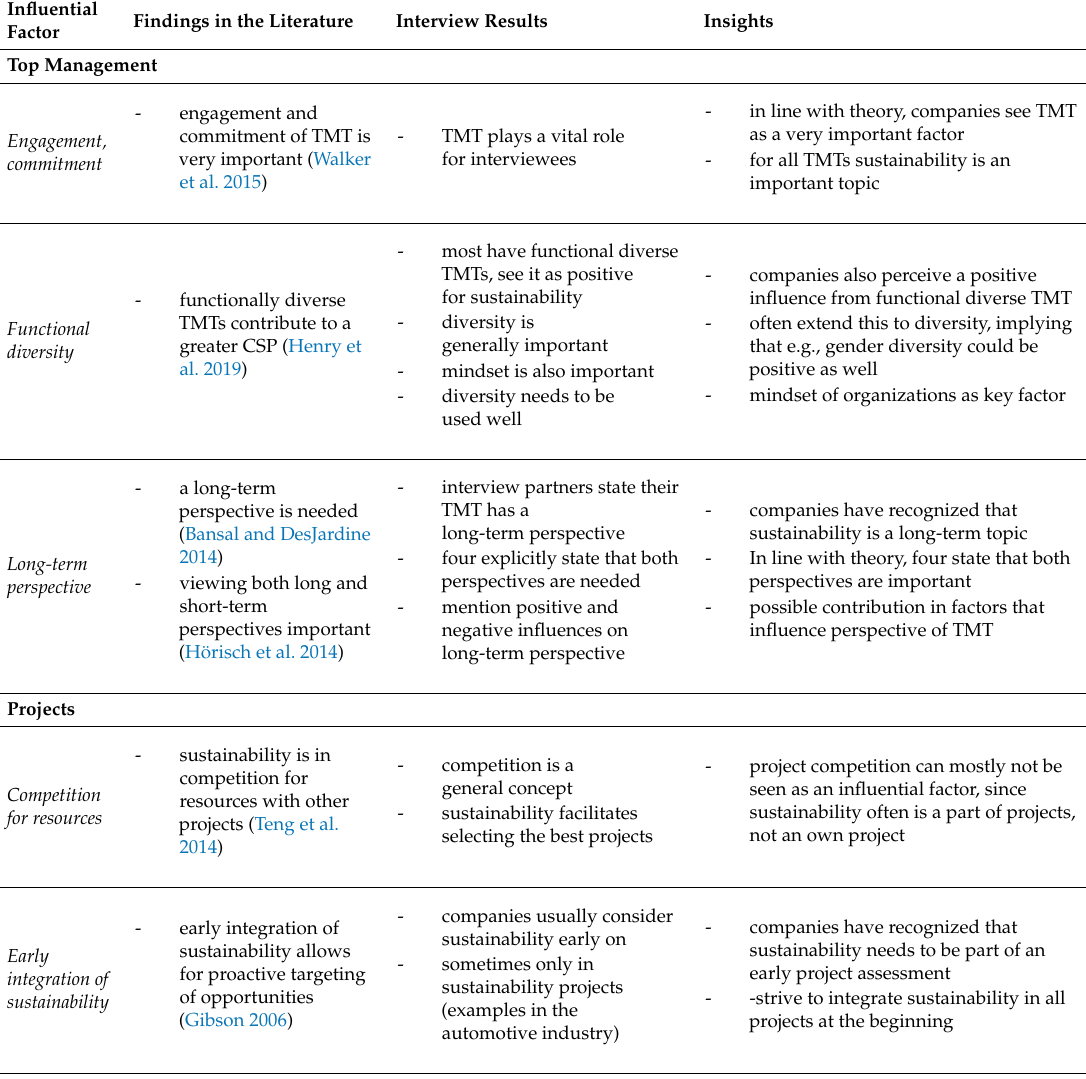
Table 11. Summary of influential factors that will not be discussed in further detail in the text as results are mostly in line with literature